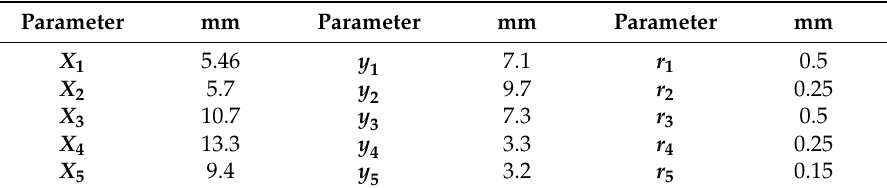
Figure 1. Three-way H-plane SIW power divider structure and parameters. Table 1. Three-way H-plane power divider dimensions